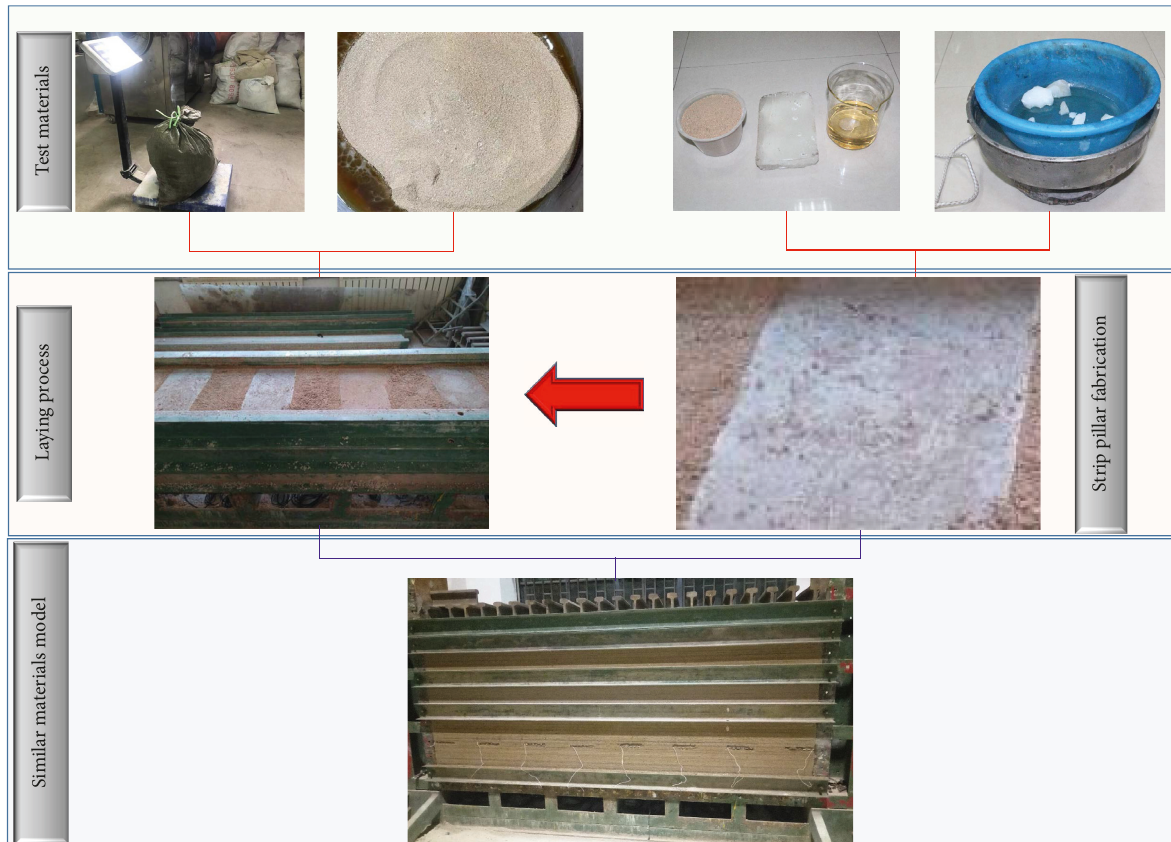
Figure 4: Temperature-controlled strips in a similar material model.